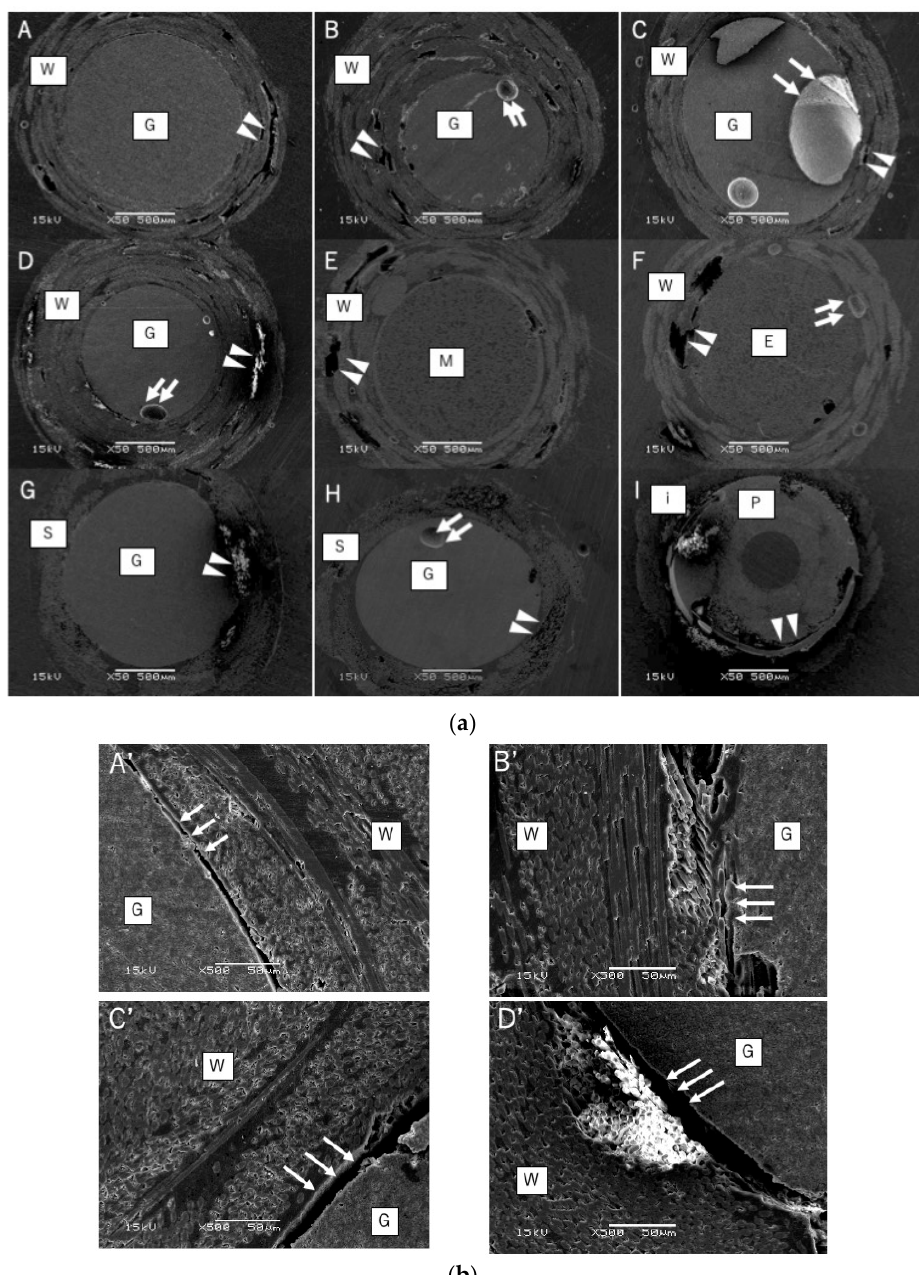
Figure 3. ( a ) SEM images (×50) of the cross-sections of fracture surfaces for various specimens. The alphabet on the upper left of each figure indicates the code of Table 2. W: woven, G: Gradia core, M: MI post, E: E-glass, S: sleeve fiber net, i: i-TFC sleeve, and P: i-TFC post. Arrowheads indicate the crush point, while arrows indicate the void. ( b ) SEM images (×500) of the cross-sections of fracture surfaces for various specimens. Each figure is an enlarged view of the same alphabet in Figure 3a. W: woven and G: Gradia core. Arrows indicate the delamination part between the outer fiber sleeve and the inner core.